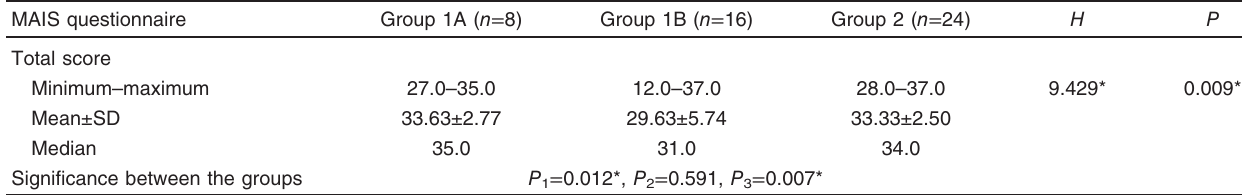
Table 4 Meaningful auditory integration scale questionnaire total scores comparison between the three groups MAIS